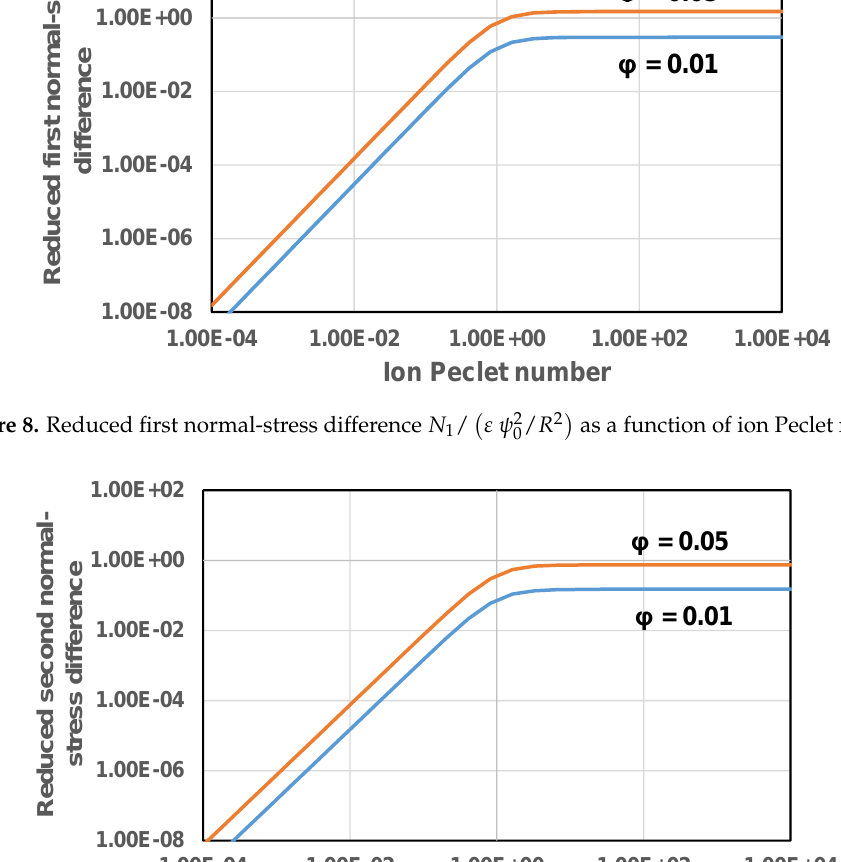
 2 20 2 R N    as a function of ion Peclet (cid:0) (cid:1)   2 20 ε ψ 2 / R 2 as a function of ion Peclet number. 2 R N    as a function of ion Peclet 0